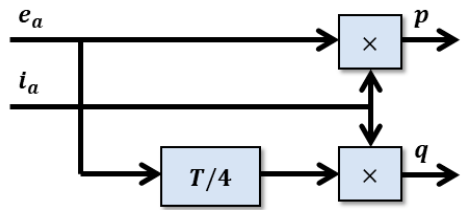
Figure 2. Power calculation with Time delay method.